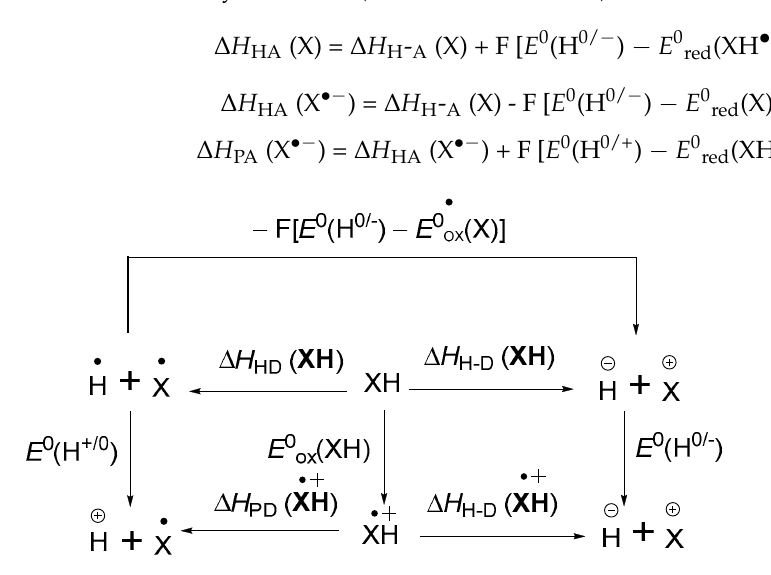
Figure 1. Thermodynamic cycles between compounds and hydrogen.